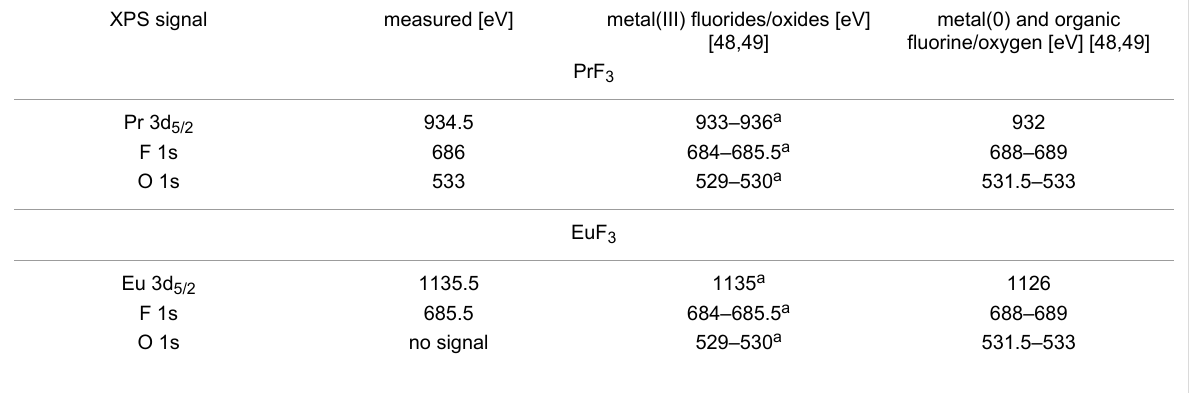
Table 2: Comparison of XPS binding energies in REF 3 -NP samples in [BMIm][BF 4